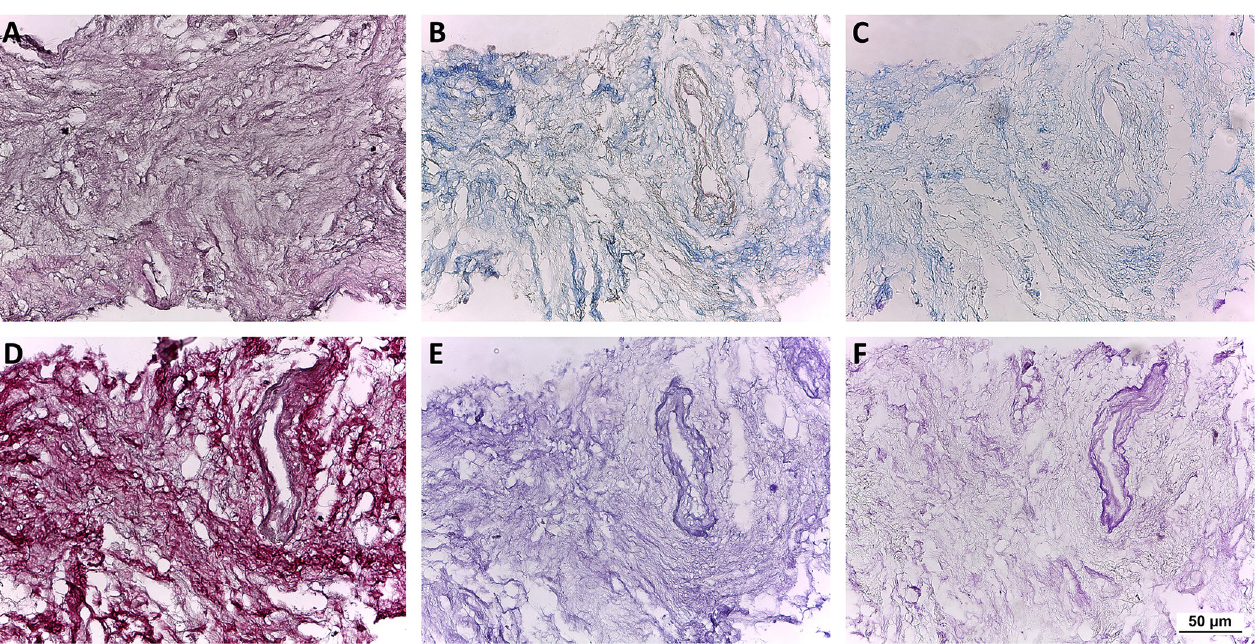
Fig 3. Evaluation of the d-ECM architecture and composition by histochemistry. Representative images of Hematoxylin and Eosin staining (A) showing no residual nuclei, Masson’s and Mallory’s Trichrome (B and C, respectively), Sirius Red (D), PAS Morel-Maronger modified (E) and Gomori’s paraldehyde- fuchsin (F) stainings on cryosections of d-ECM showing collagen fibers stained blue (B-C) or red (D), glycoproteins stained violet (E) and elastic fibers stained pink (F). Scale bar length is 50 μ m. https://doi.org/10.1371/journal.pone.0276224.g003 PLOS ONE | https://doi.org/10.1371/journal.pone.0276224 October 19,